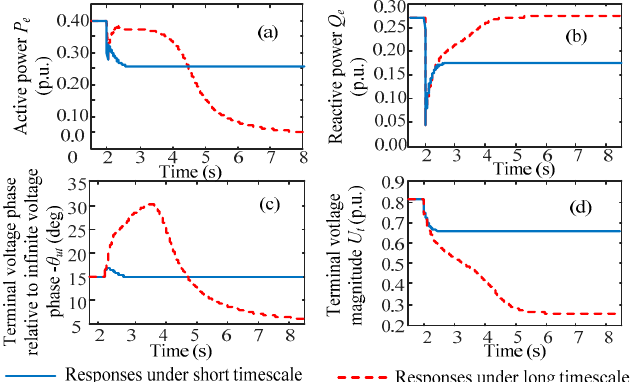
Figure 7. Dynamic response of IM loads under short timescale (solid) and long timescale (dashed) disturbances: ( a ) active power; ( b ) reactive power; ( c ) terminal voltage phase relative to the infinite voltage phase; ( d ) terminal voltage magnitude.